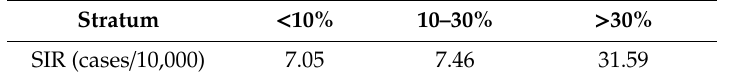
Table 4. SIR of lung cancer according to the percentage of industrial land